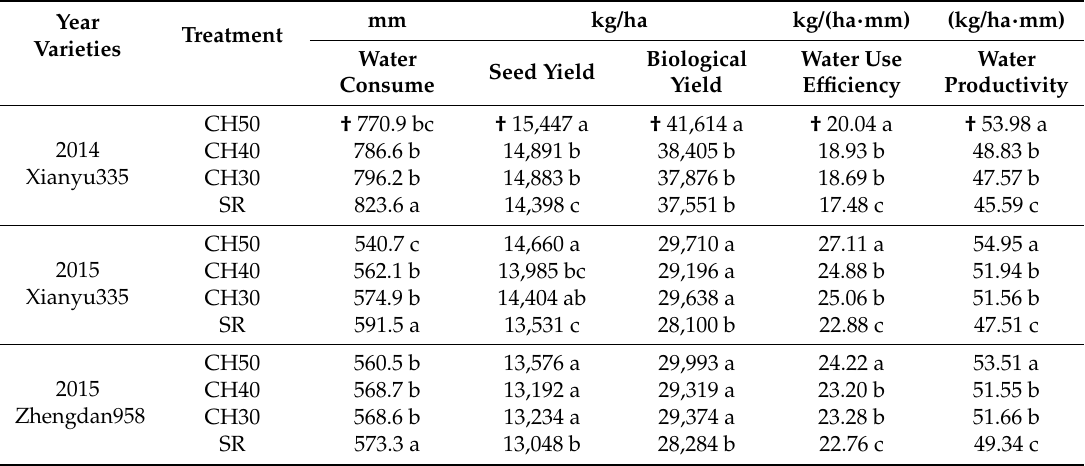
Table 8. Water use efficiency of spring maize under different tillage depths. Values are the mean of three replications.